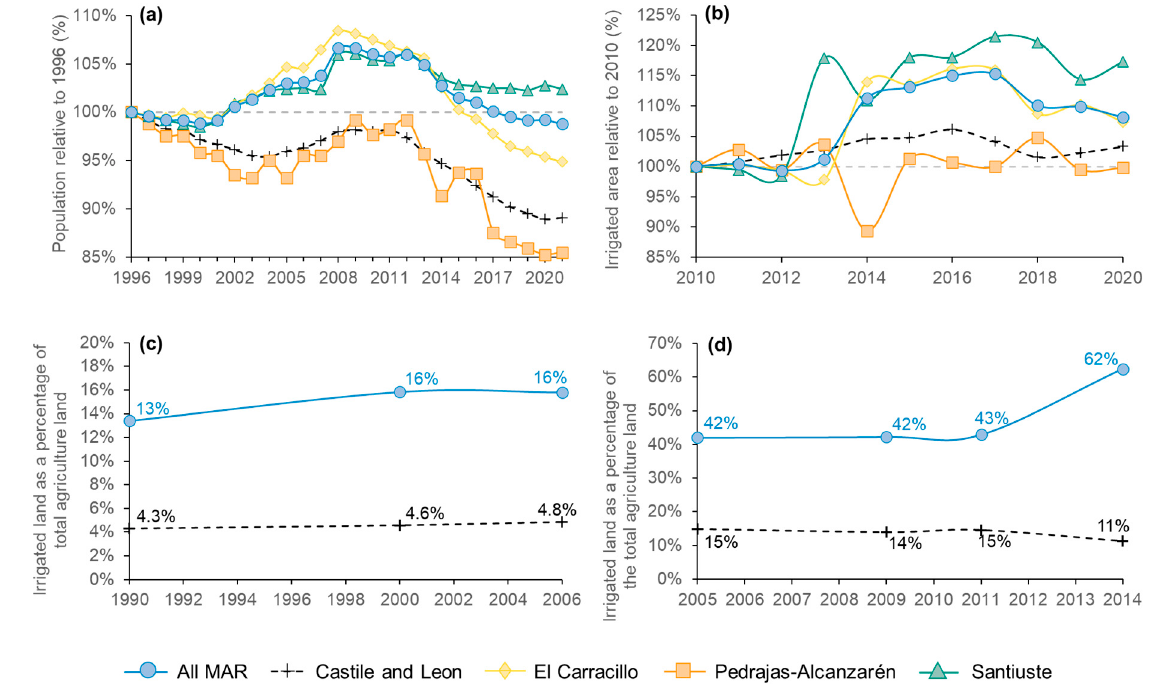
Figure 6. Population and agricultural land dynamics in the areas with managed aquifer recharge (MAR) and Castile and Leon (CyL): ( a ) population relative to 1996, ( b ) irrigated land change relative to 2010, ( c ) irrigated land as a share of total agriculture between 1990 and 2006 using CORINE Land Cover (CLC), and ( d ) irrigated land as a share of total agriculture between 2005 and 2014 using the Spanish Land Occupation Information System (SIOSE). All MAR combines the data from El Carracillo, Pedrajas-Alcazarén, and Santiuste.